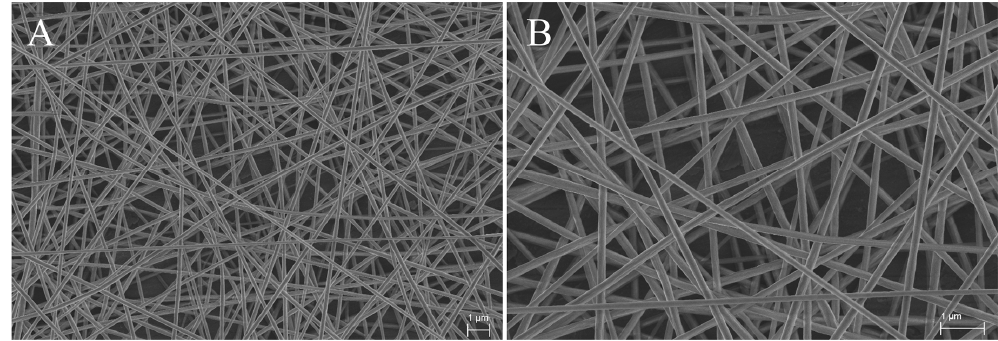
Figure 1. Selected SEM images of a typical electrospun PAN nanofiber phase taken at a magnification of 5000× ( A ) and 10,000× ( B ).